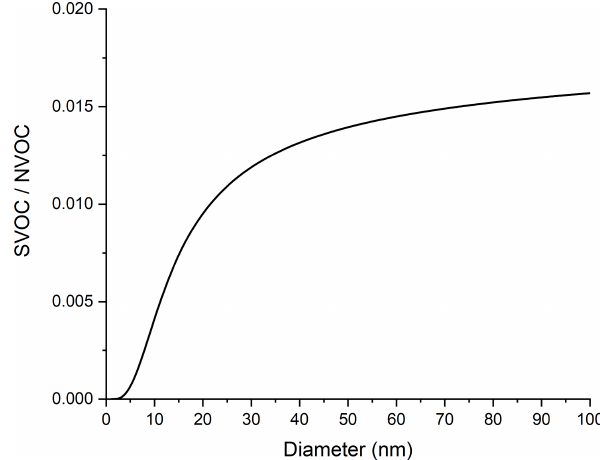
Figure 2. Mass fraction ratio of SVOC / NVOC vs. particle diame- ter under conditions where growth occurs by partitioning